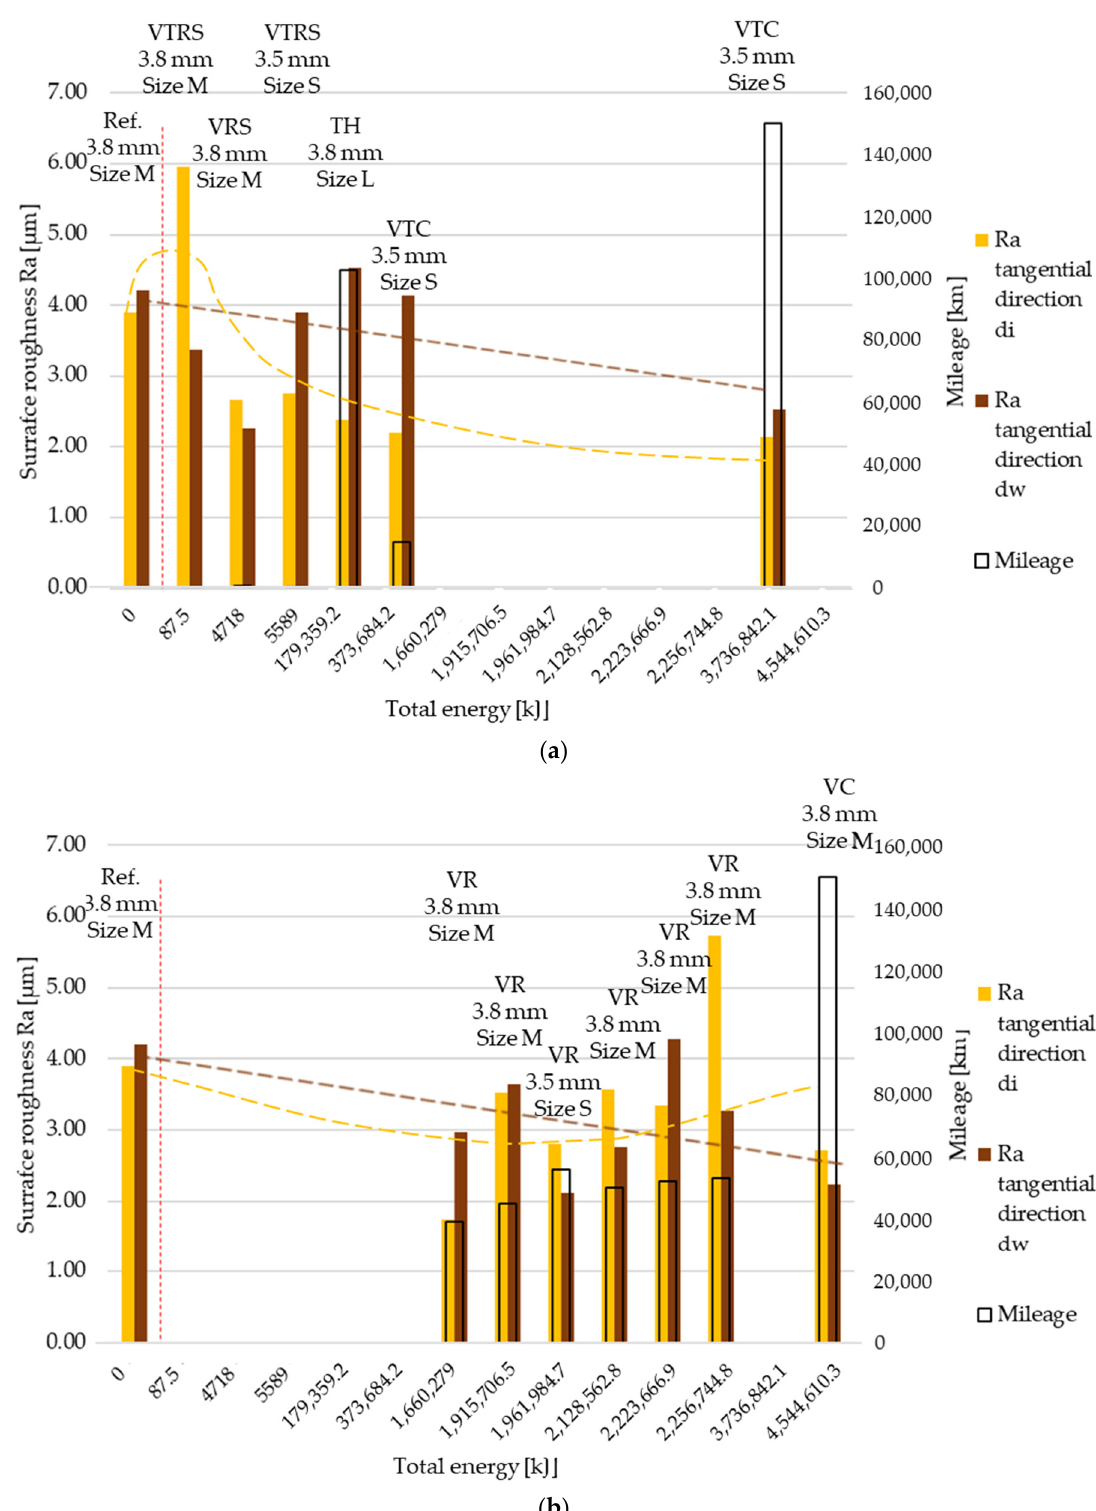
Figure 6. ( a ) Ra surface roughness values, tangential direction–trend 1: clutch killer tests. ( b ) Ra surface roughness values, tangential direction–trend 2: moderate tests.